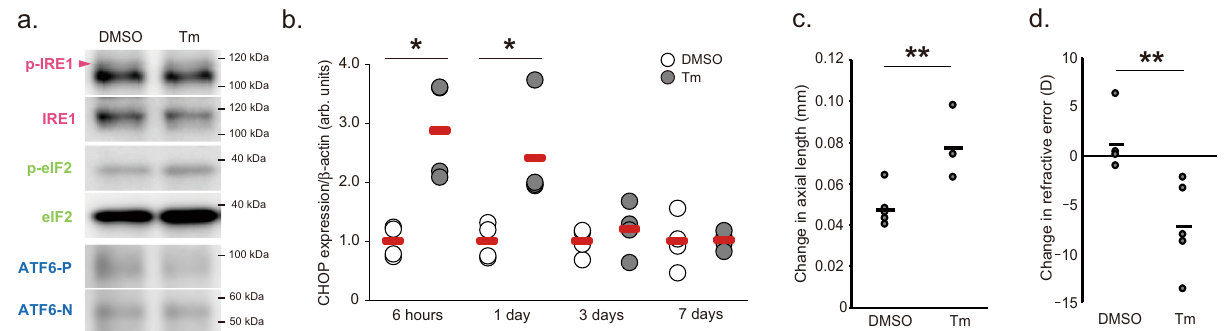
control; Student ’ s two-tailed t -test (Exact p values are as follows: 6h, p =0.017; 1 day, p =0.024). c A single Tm (50 µ g/mL) instillation induces axial elongation ( n =5 per group); ** p <0.01; Student ’ s two-tailed t -test ( p =0.003). d A single Tm instillationinducesmyopicshiftinrefraction( n =5pergroup);** p <0.01;Student ’ s two-tailed t -test ( p =0.009). Source data are provided as a Source Data fi le.